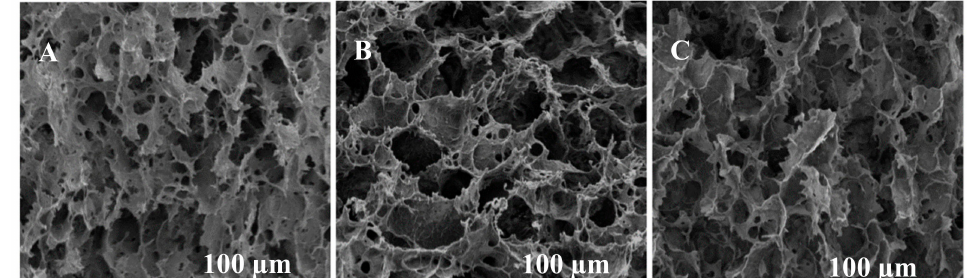
Figure 6. SEM micrograph of fracture surface of sca ff olds: neat PHBV ( A ), PHBV / 5% WOL-S ( B ), PHBV / 10% WOL-S ( C ) with 1000x